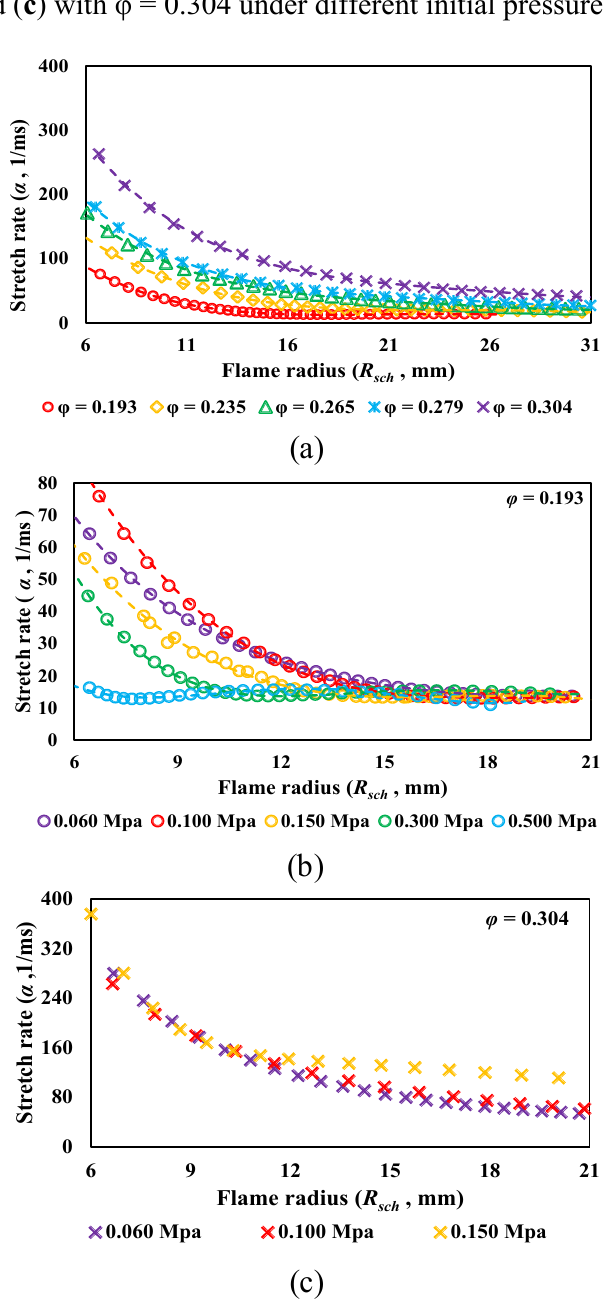
Figure 11. Global stretch rate of hydrogen-air premixed flames with flame radius: ( a ) with different equivalence ratios under atmospheric pressure; ( b ) with φ = 0.193 under different initial pressures; and ( c ) with φ = 0.304 under different initial